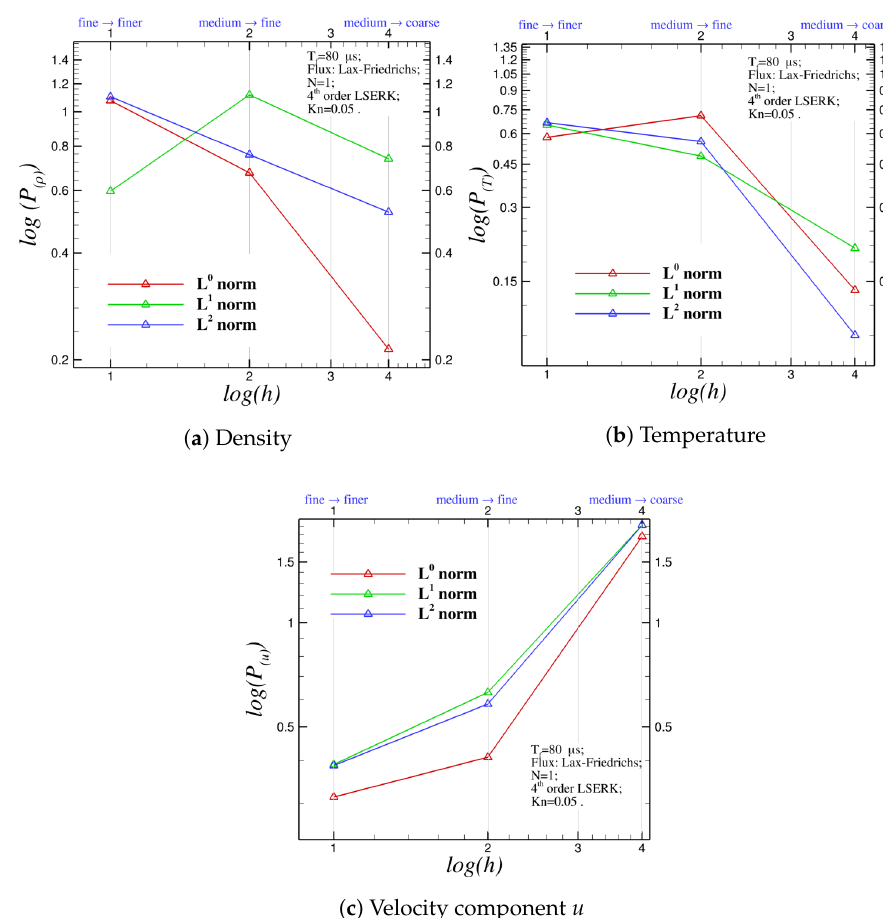
Figure 6. Logarithmic plots of the observed order of accuracy P using the L 0 , L 1 and L 2 norms of the absolute error between the results achieved with DG–FEM and reference data in [21] against the dimensionless grid spacing h . Results presented for: density ( a ); temperature ( b ) in the centerline of the microchannel; and streamwise velocity ( c ) in the cross section x = 25 H . Results obtained at the final time T f = 80 µ s with Kn = 0.05. Table 5. Observed order of accuracy P for density, temperature and u velocity based on L 0 , L 1 and L 2 norms of the absolute error between numerical solution obtained with DG–FEM and numerical data in